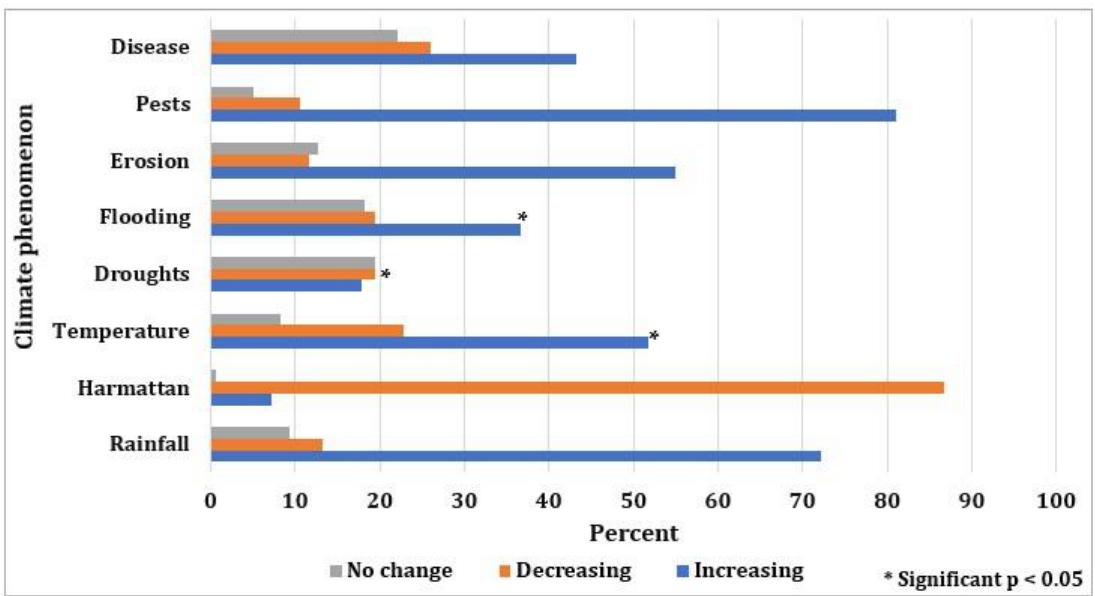
Figure 6. Perception of farmers on the impacts of climate change. Where (*) represents the signifi- cance of the variables at a 95% confidence level, and years of farming experience is used as the determining factor for variation in perception/response.